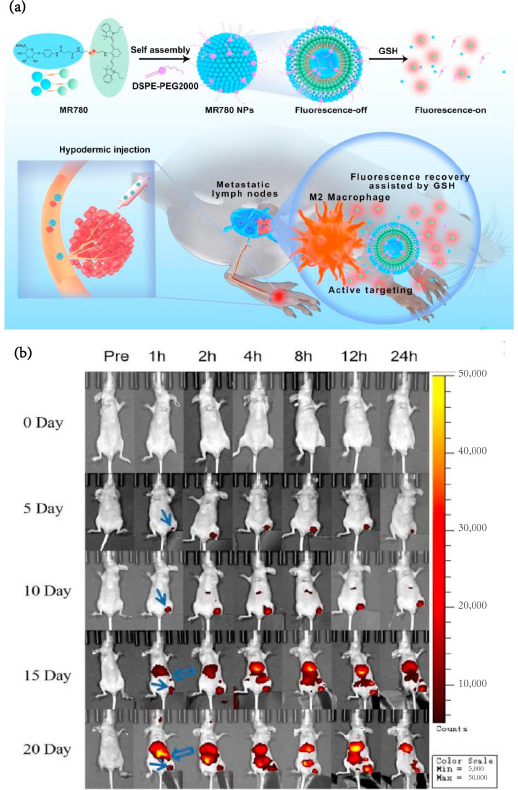
Figure 9. ( a ) Schematic diagram for the fabrication and function of MR780 NPs: 4-aminophenyl α -d-pyranoside and IR780 was connected via cystamine to obtain MR780 conjugate, and then self- assembled with DSPE-PEG2000 to prepare MR780 NPs. ( b ) Fluorescence imaging of lymph nodes in normal mice and plantar 4T1 tumor-bearing mice every 5 days [91]. Copyright 2022, Elsevier.